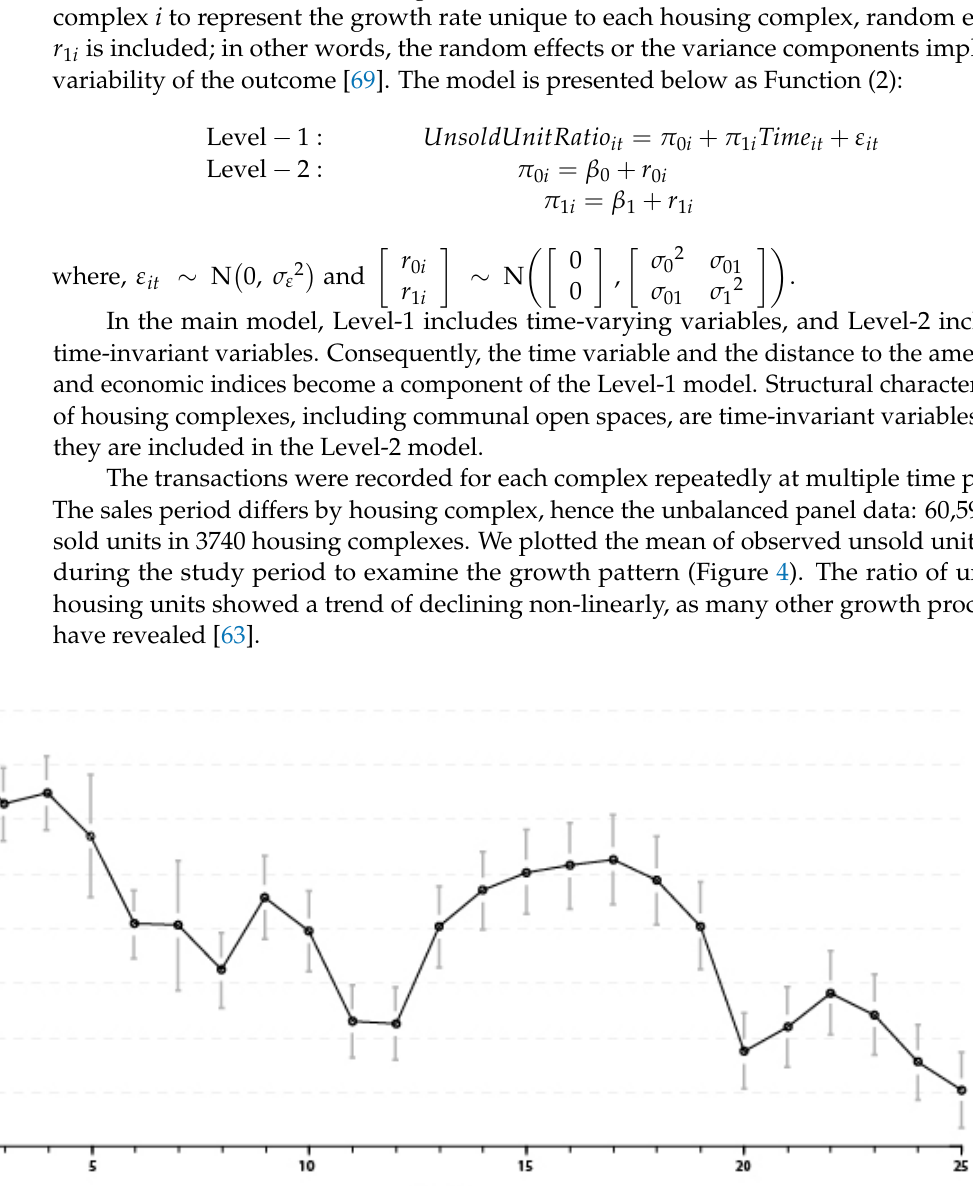
interaction term with the time variable in the model. We initially compared the